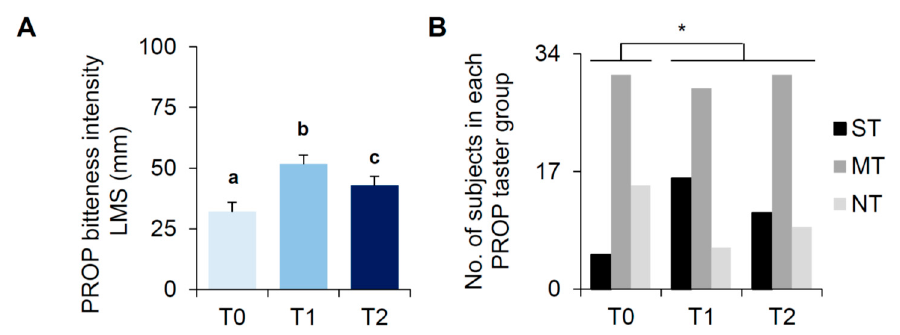
Figure 1. 6-N-propylthiouracil (PROP) tasting before (T0), one month (T1) and six months (T2) after bariatric surgery. Means ( ± SEM) values of PROP bitterness intensity ratings (50 mM) ( A ) and numbers of subjects classified as super-tasters (STs), medium tasters (MTs), and non-tasters (NTs) ( B ). ( n = 51). Different letters in ( A ) indicate significant difference ( p ≤ 0.037, Fisher’s test least significant difference (LSD) subsequent repeated measures ANOVA). * in ( B ) indicates a significant difference ( p = 0.0078; Fisher’s exact).